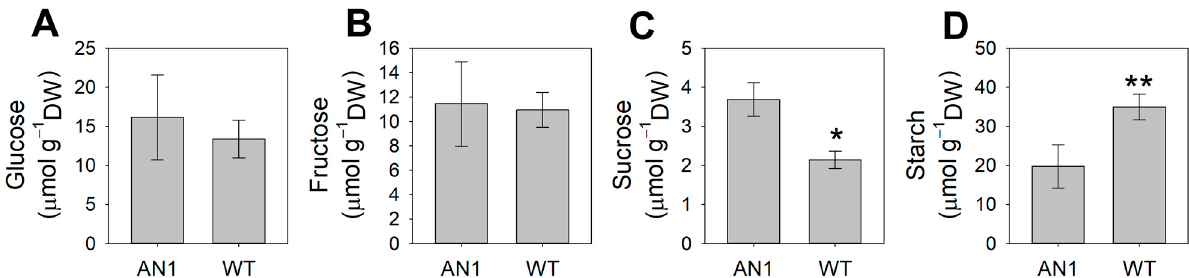
Figure 7. Lignin leaf content in AN1 and WT plants. Asterisks indicate significant differences according to ANOVA (*** p < 0.001).